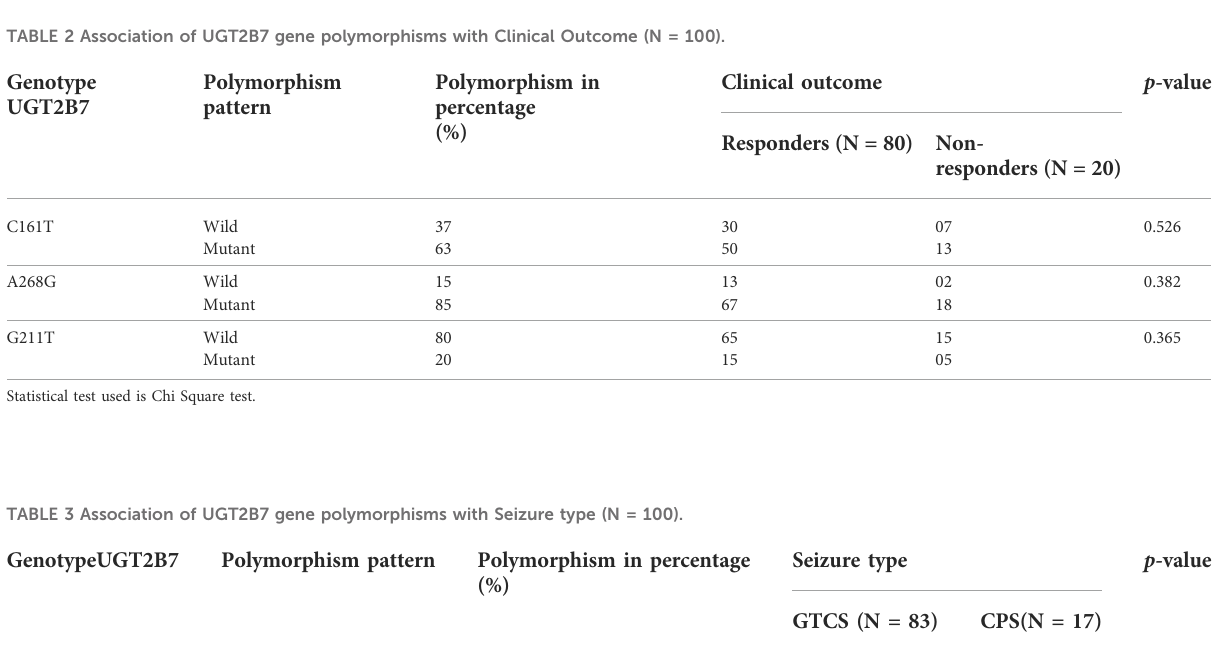
TABLE 2 Association of UGT2B7 gene polymorphisms with Clinical Outcome (N = 100).